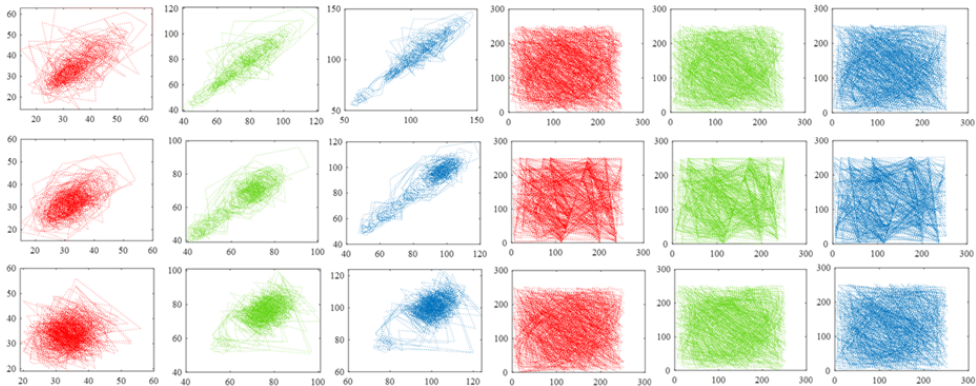
Figure 10. Correlation values of adjacent pixels of image football. The first, second, and third columns are drawn based on adjacent pixels from the red, green, and blue channels of the original image, and the fourth, fifth, and sixth columns are drawn based on adjacent pixels of signal Y c . The three rows show the results calculated from horizontal, vertical, and diagonal directions, respectively. The compression rate is